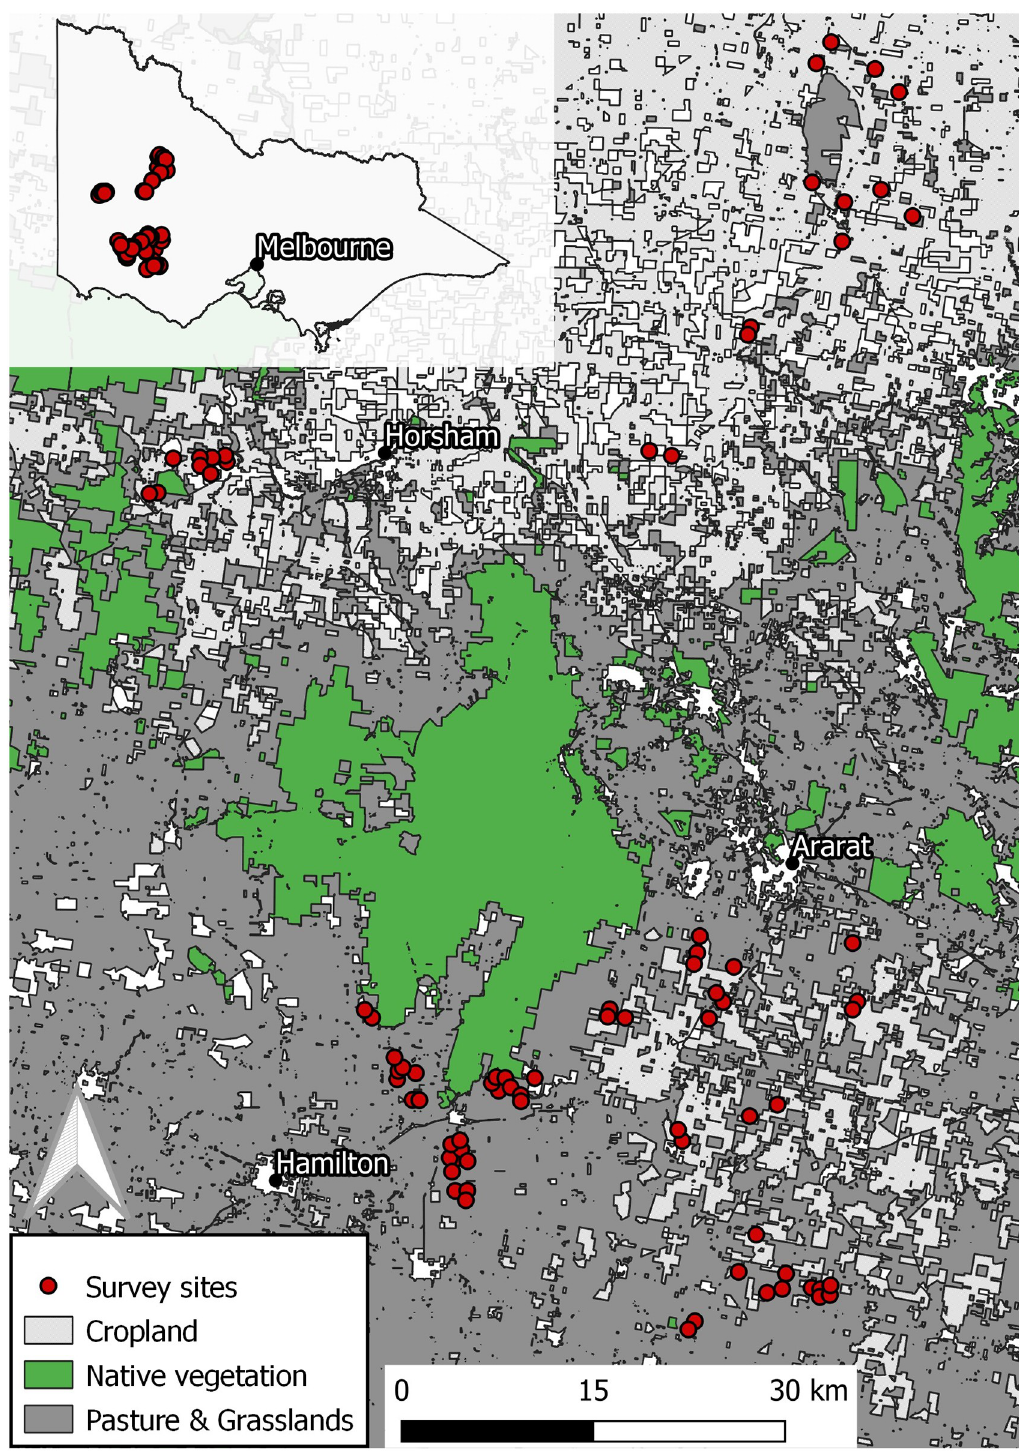
Fig 1. Map of sites used to assess the effectiveness of ‘quail caller’ Electronic Acoustic Lures (EALs) to attract stubble quail ( Coturnix pectoralis ) on private properties in western Victoria, south-eastern Australia, 2021.